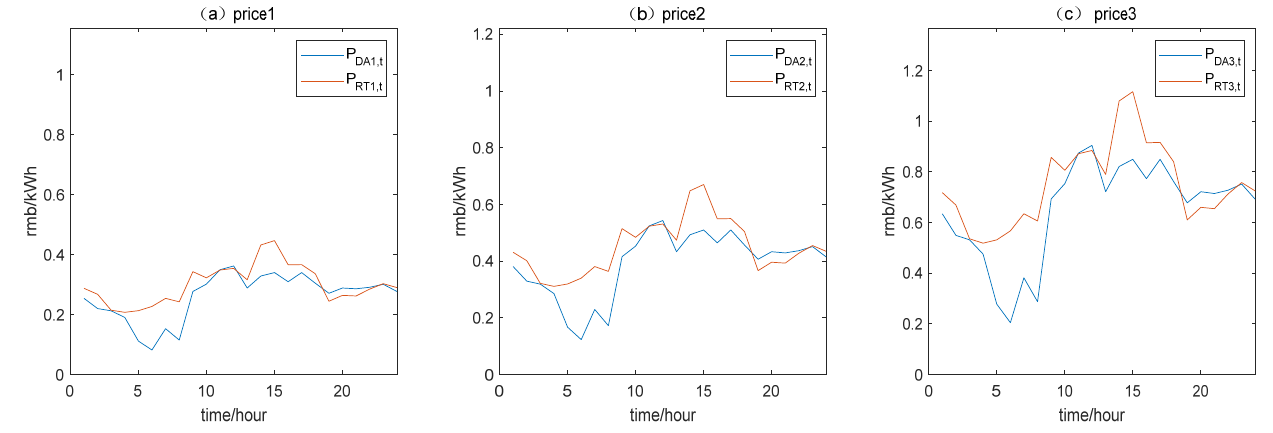
Figure 17. Day-ahead and real-time electricity prices in different ranges. Table 4. Average kilowatt-hour price based on three DA prices. Price1 Price2 Price3 Average kilowatt-hour DA price 0.261 0.391 0.651